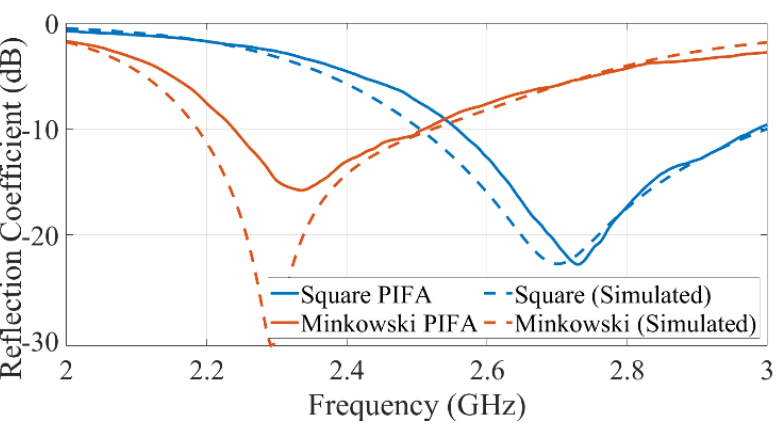
Figure 11. Comparison of measured and simulated reflection coefficient for the manufactured